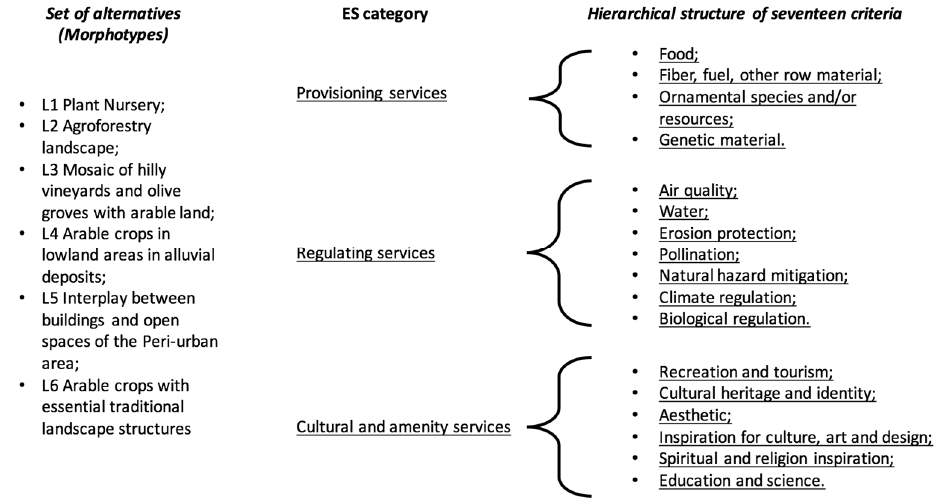
Figure 3. Design of the study.